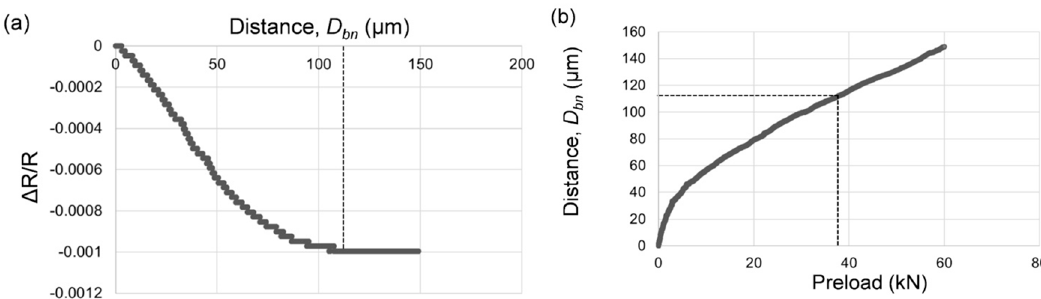
Figure 9. Conductive line screen-printed near the nut bearing surface using carbon paste.